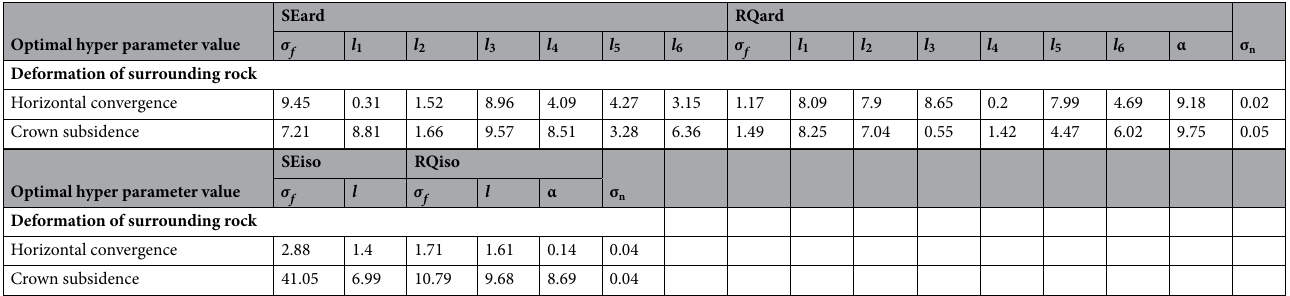
Table 5. Optimal hyperparameters of the best IGPR model.